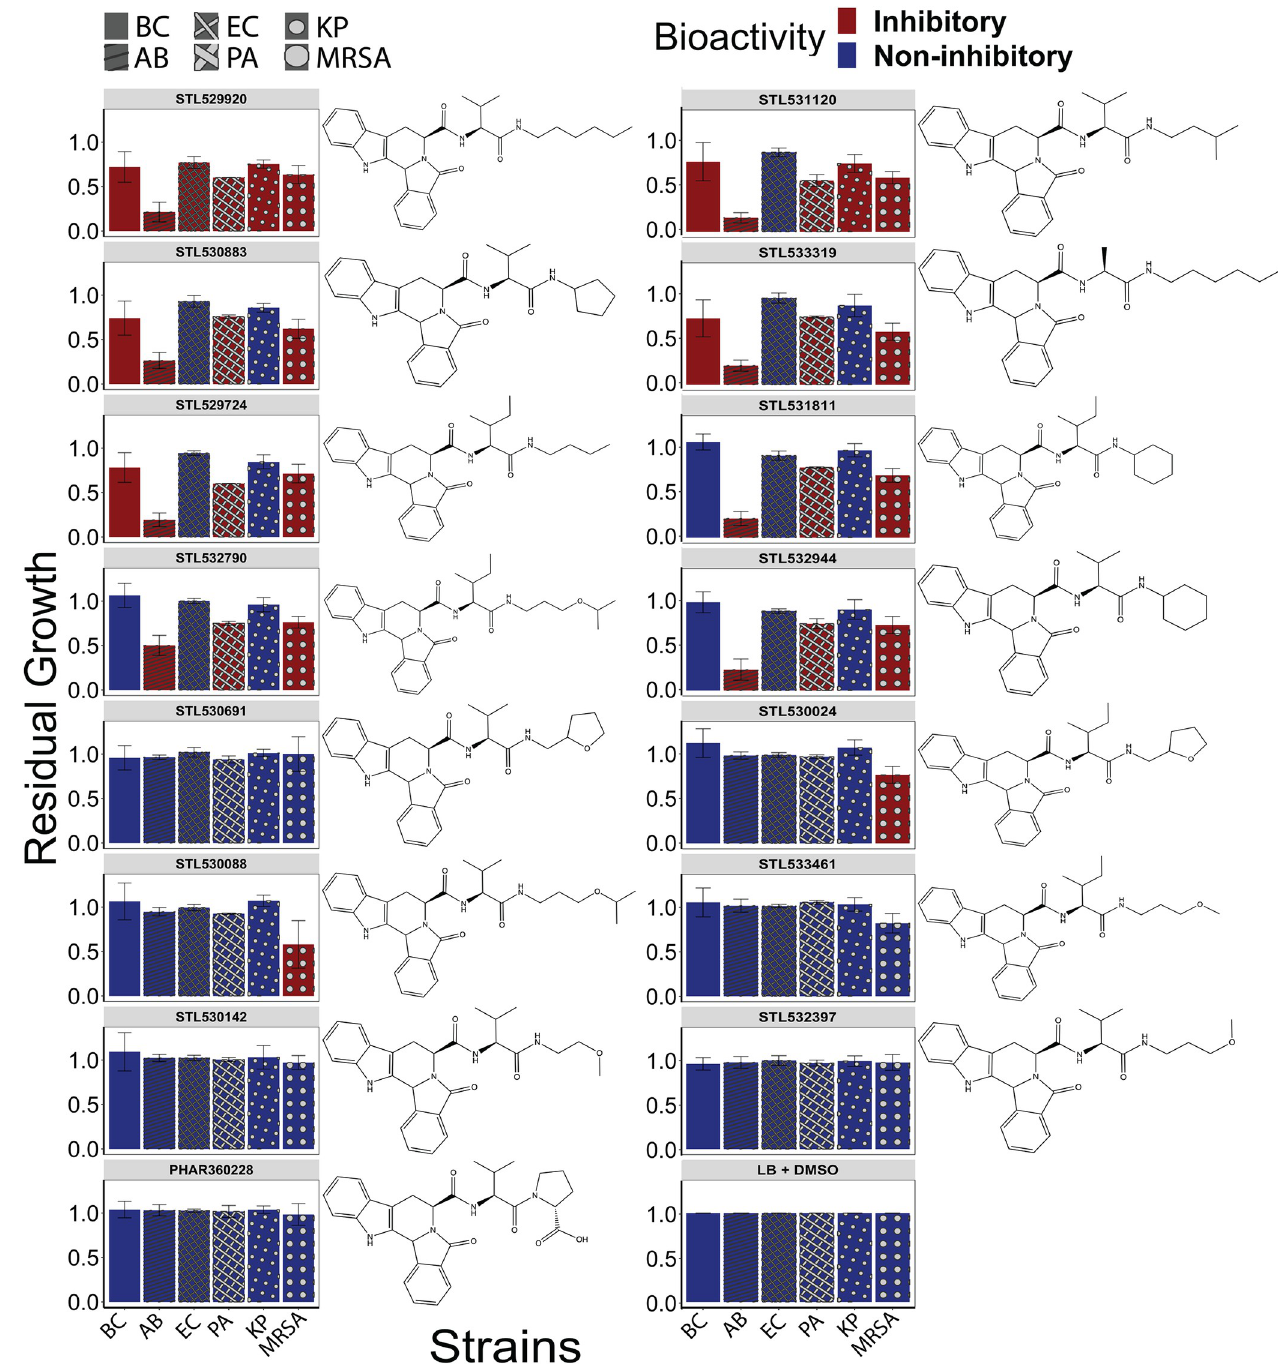
Fig 6. Screening of PHAR261659 analogs. PHAR261659 analogs with different side chains were selected based on lower predicted logP values. STL529920, a stereoisomer of PHAR261659, exhibited growth inhibitory activity against all six pathogens tested. The activity of growth inhibitory and non-growth inhibitory compounds are shown in red and blue, respectively. Results are the average of three independent biological replicates. Error bars indicate mean ± SD.